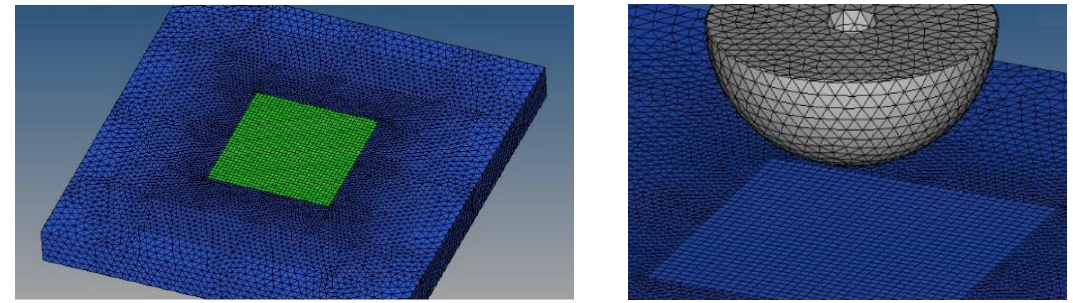
Figure 3. EFG model: Pad foam with the impact zone highlighted in green ( Left ) and missile ( Right ).